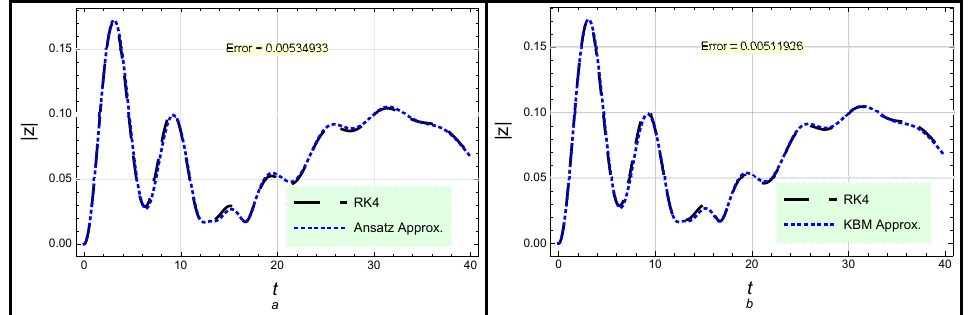
Fig. 4 Figure 4. ( a ) The analytic approximation (29) using the ansatz method and ( b ) the analytic approxi- mation (45) using the KBM method for the absolute value of | z | are compared with the numerical RK4 approximations of the i.v.p. (6).